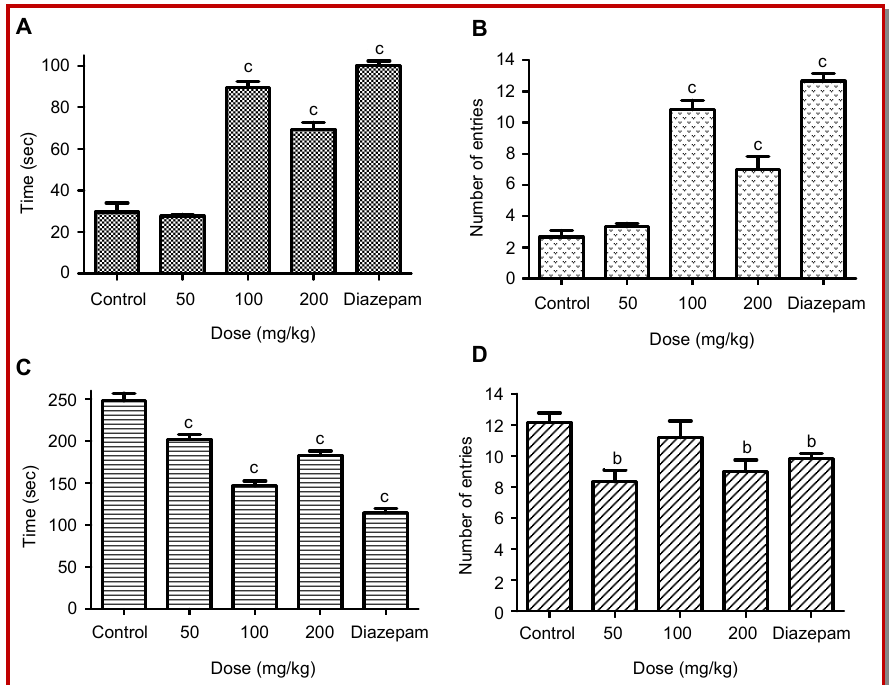
Figure 1: Effect of crude extract of C. annum at test doses in elevated plus-maze model. Time spent in open arm (A), Number of entries to open arm (B), Time spent in close arm (C), Number of entries to closed arm (D). Control (Saline and tween 80 2.5%), 50,100,200 mg/kg (crude extract of C. annum ), and Diazepam 1 mg. All values are expressed as mean ± SEM, n = 6., a p<0.05, b p<0.01, c